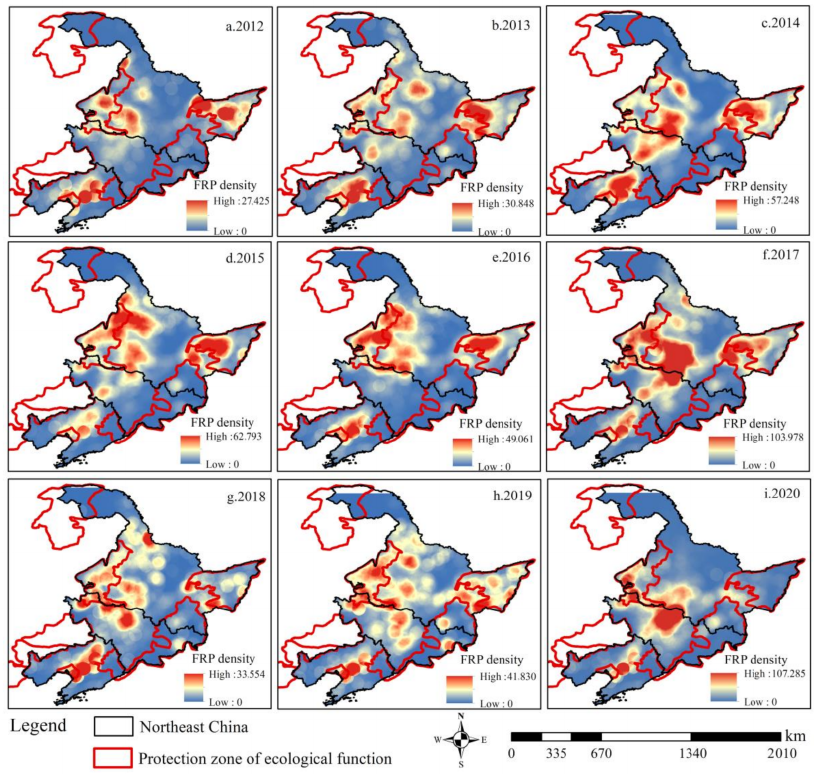
Figure 4. Spatial characteristics of fire radiation power (FRP) of VIIRS active fires in Northeast China during